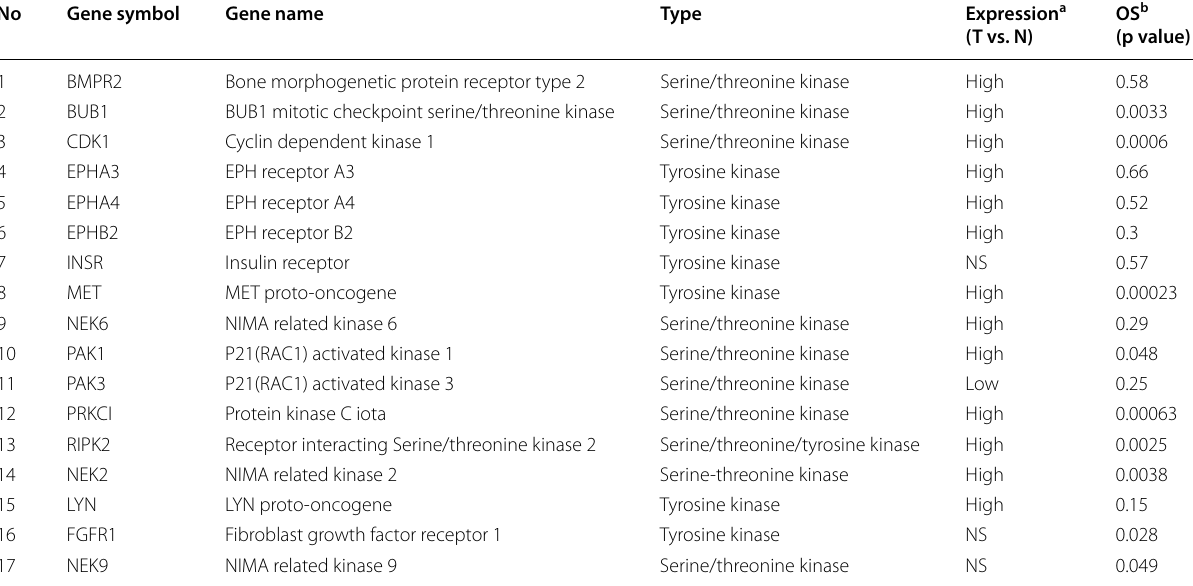
a Gene expression comparison between Tumor and the normal (T vs. N); b overall survival analysis based on TCGA